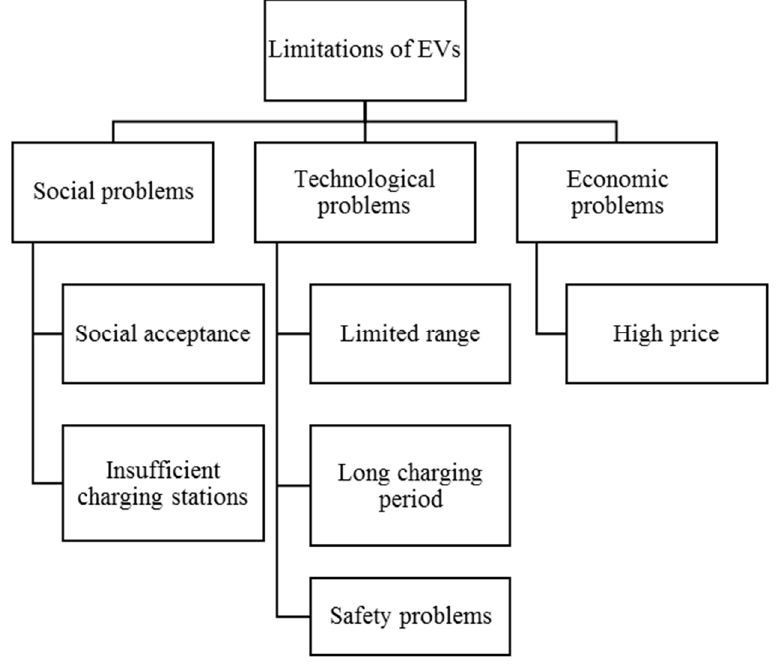
Figure 64. Social, technological, and economic problems faced by EVs. Table 28. Hurdles in key EV factors. Adapted from [170]. Table 28. Tentative solutions of current limitations of EVs.